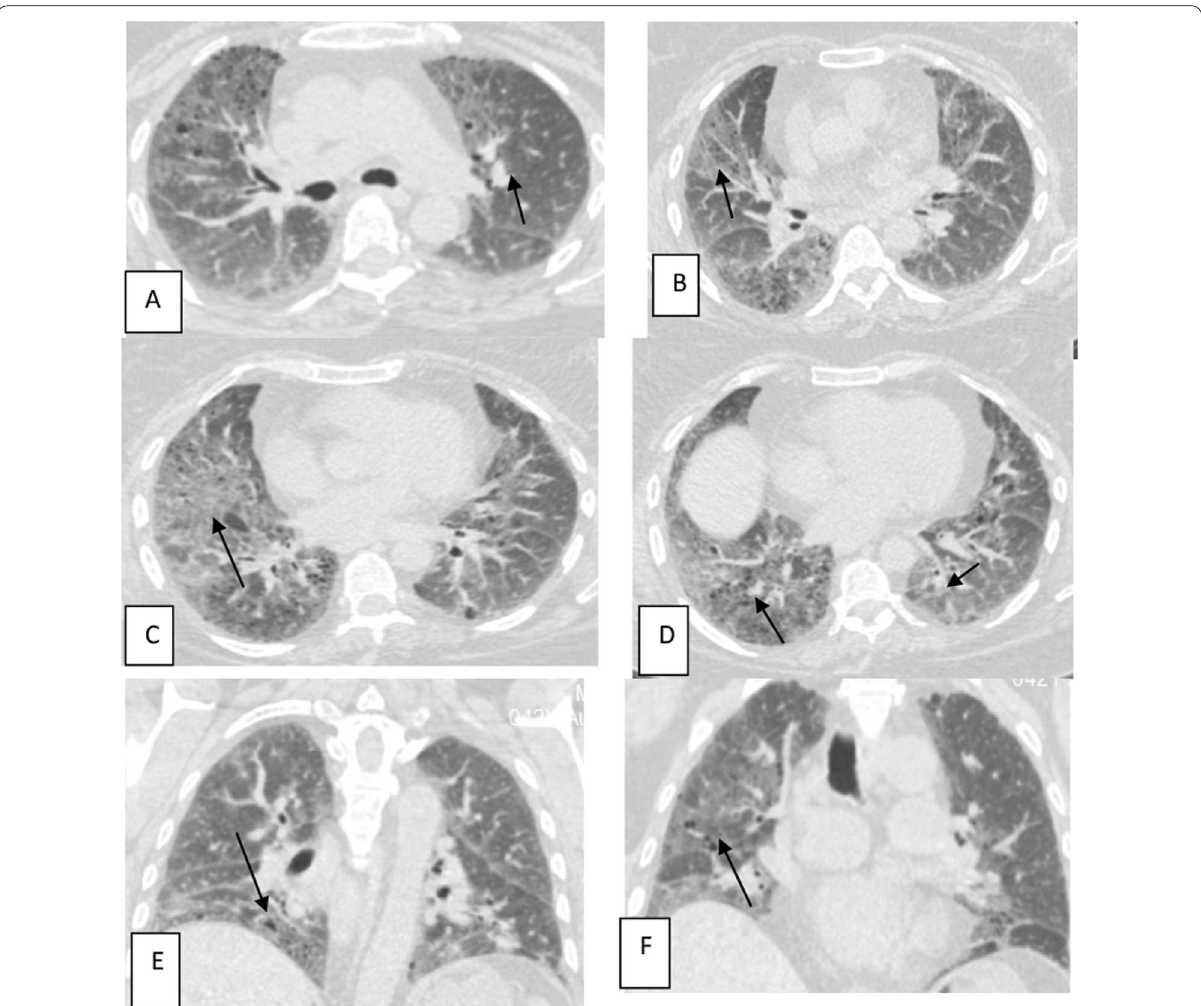
Fig. 7 Female patient aged 35 years old, with history of COVID‑19 infection 3 month ago, presented by dyspnea on exertion and tachypnea. Axial ( A – D ) and coronal ( E , F ) CT images show multiple patchy areas of ground‑glass density with reticular infiltration and interlobular septal thickening, associated with multiple tiny cysts (< 1 cm) (black arrows); with lower lobes predominance, these changes are consistent with post‑COVID‑19 interstitial lung